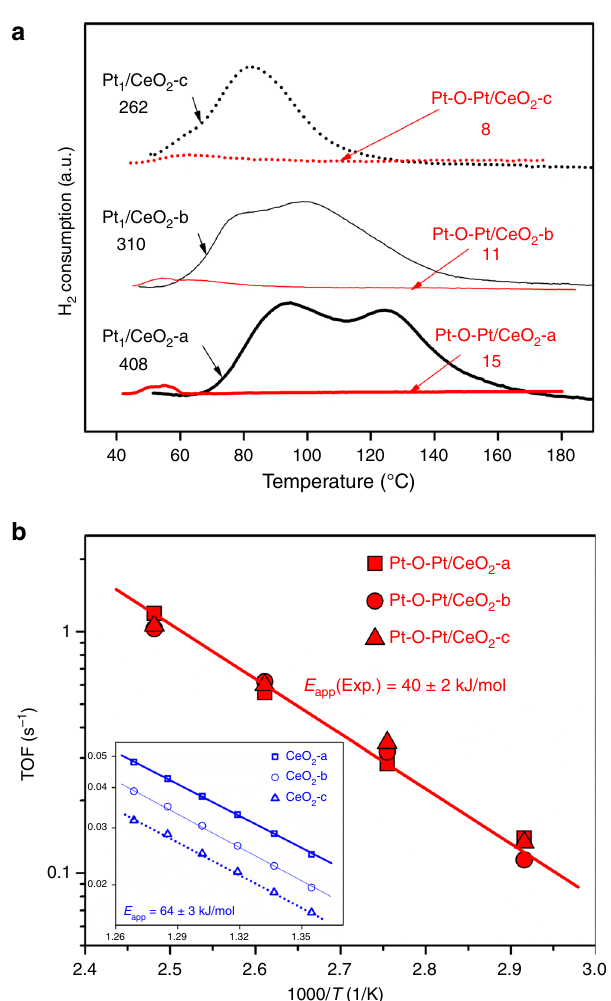
Fig. 5 Catalyst surface [O] reducibility and site-speci fi c turnover frequencies (TOFs) for CO oxidation reaction. a H 2 temperature programmed reduction (TPR) pro fi les and integrated amounts of reducible [O] for the Pt 1 /CeO 2 and Pt-O-Pt/CeO 2 catalysts. The labeled values in a are the integrated amount of reducible oxygen with the default unit of “ µ mol [O]/g ” b Identical TOFs were found for the Pt-O-Pt/CeO cat . catalysts and different TOFs were found for the Pt-free ceria